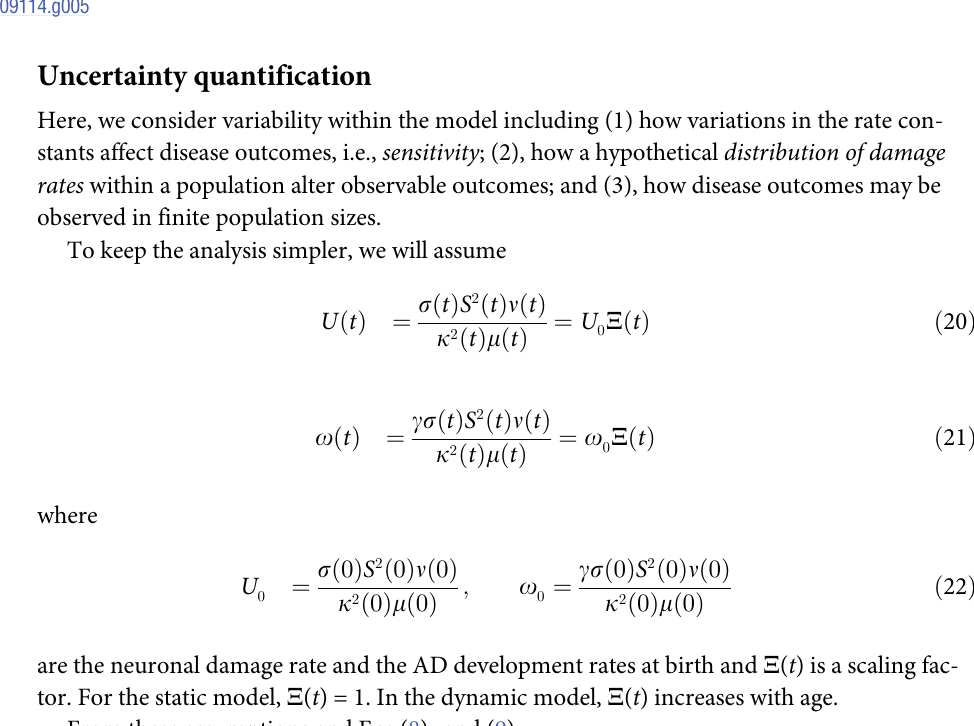
Fig 5. Spatial model. A : the excess monomer production is taken to be spherically symmetric. The distance ( x − axis) denotes the distance from the center of the source. The dashed circle/lines represent the boundary where excess monomer production ceases. B : monomer and dimer concentrations, and monomer production rate, versus distance from center. These values have been nondimensionalized by � M , � D , and � S , respectively. C : viability at various ages plotted against position.